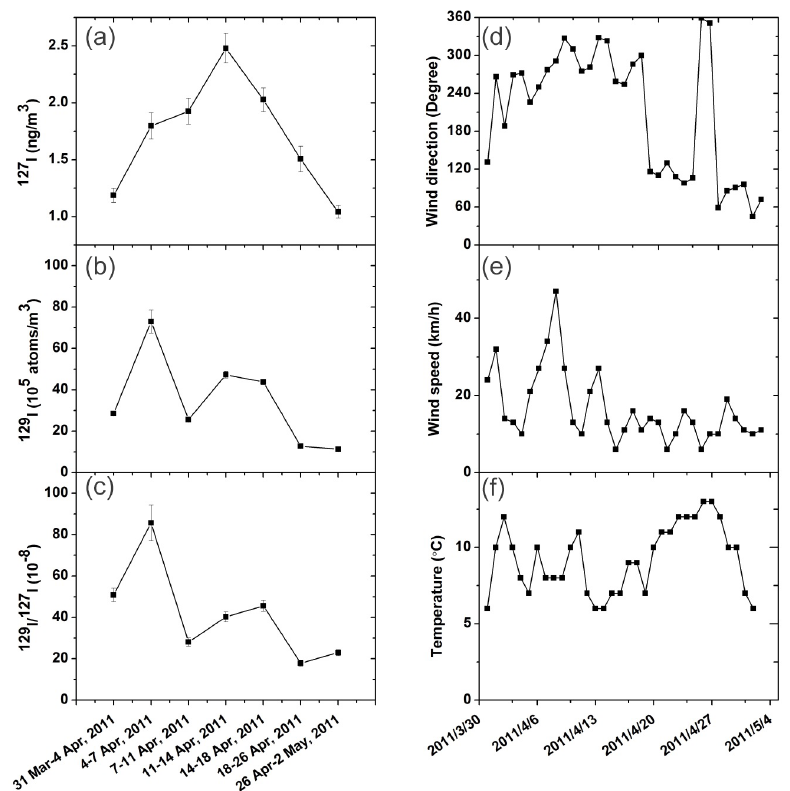
Figure 3. Variation of 127 I concentrations (a) , 129 I concentrations (b) , 129 I / 127 I ratios in aerosols (c) , wind direction (d) , wind speed (e) , and temperature (f) during the sampling period. The historical meteorological data, including temperature, wind direction, and wind speed were obtained from the observation station of Hangarvej in Roskilde, Denmark (55.594 ◦ N 12.128 ◦ E) based on 41ma.s.l. (above sea level) (Weather Wunderground webpage,